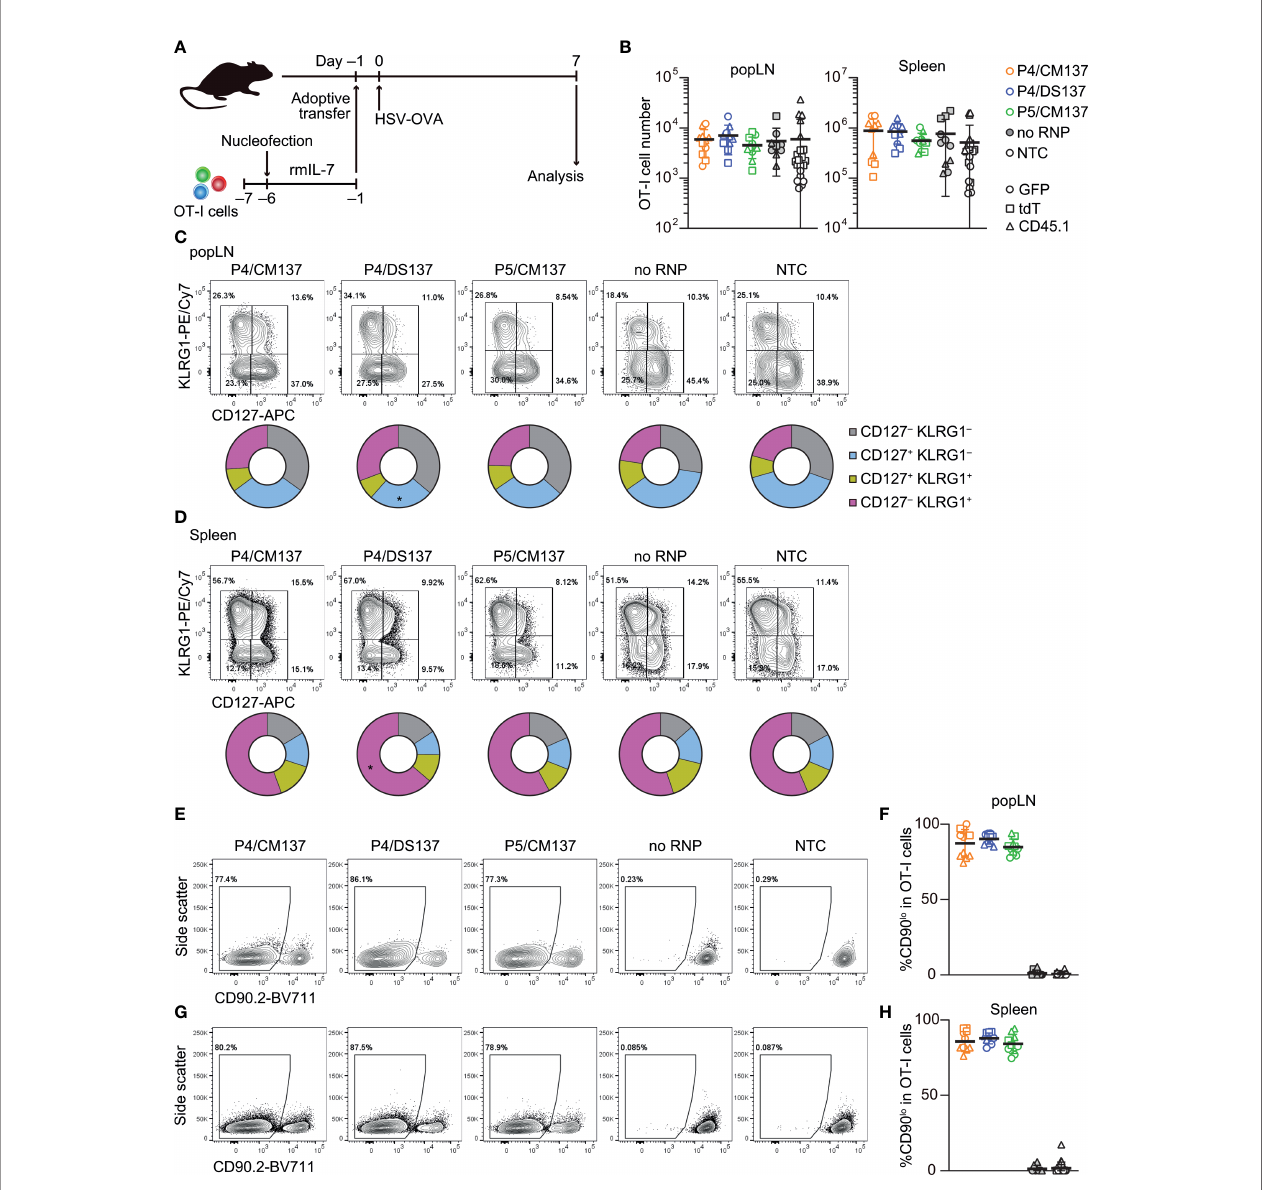
FIGURE 6 | In vivo antiviral immune response of nucleofected naïve CD8 + T cells. (A) Experimental scheme. OT-I cells were nucleofected with three CD90 crRNAs using P4/CM137, P4/DS137 or P5/CM137. One day before subcutaneous HSV-OVA infection, 5,000 OT-I cells per group (a total of 15,000 cells per mouse) were injected into hosts. Each recipient received three groups including freshly isolated OT-I cells. (B) OT-I cell number on day 7 post-infection. No statistically signi fi cant difference between nucleofected groups and freshly isolated OT-I cells by Kruskal-Wallis test with Dunn ’ s multiple comparison (popLN) or ordinary one-way ANOVA with Dunnett ’ s multiple comparison (spleen). (C, D) CD127 and KLRG1 expression on OT-I cells in popLN (C) and spleen (D) on day 7. * p < 0.05 as compared to NTC by ordinary two-way ANOVA with Dunnett ’ s multiple comparison. (E – H) Frequency of CD90 lo cells in OT-I cells in popLN (E, F) and spleen (G, H) on day 7. Flow cytometric plots are gated on viable OT-I cells identi fi ed by the expression of congenic markers and show concatenated data from one of three experiments with n = 5 per group. Congenic marker assignment was swapped in each experiment. Graphs show pooled data from three independent experiments with n = 10 – 11 or 21 – 22 for nucleofected groups and freshly-isolated cells,